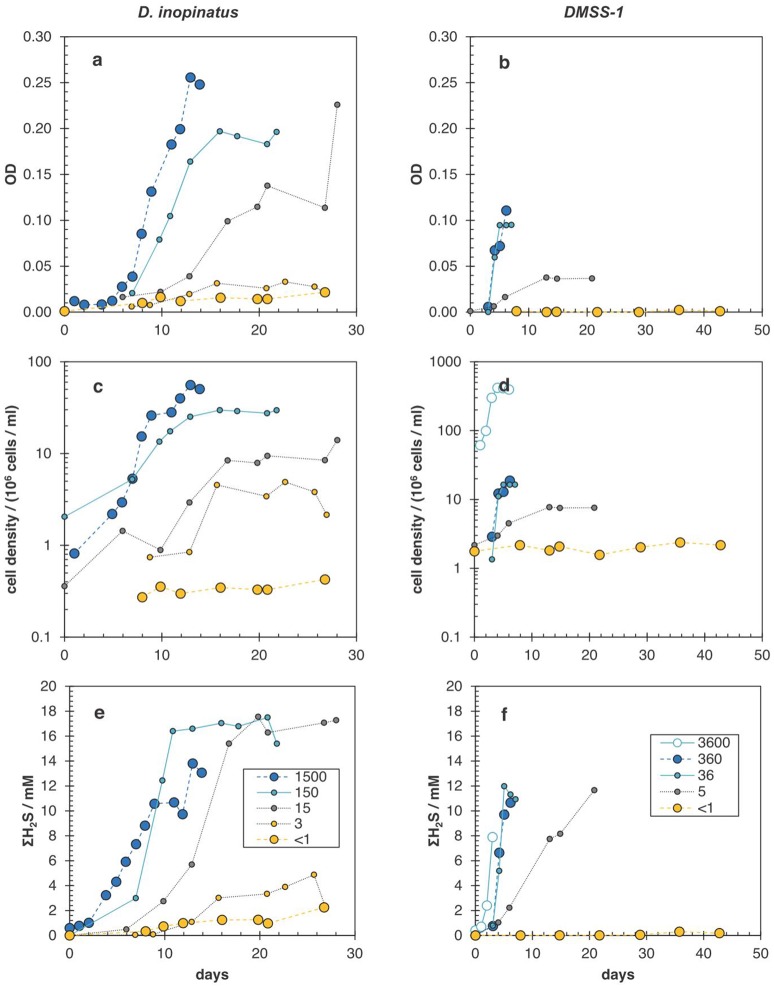
Growth curves showing optical density of cultures (a,b), cell densities determined by epifluorescence microscopy (c,d), and total sulfide (ΣH2S) concentration (e,f) in batch cultures of D. inopinatus (left) and DMSS-1 (right) grown on lactate in the presence of different initial phosphate concentrations (in μM; legend shown in bottom panels). Data are from Tables 2, 3, with the exception of the data for DMSS-1 cultures grown at 3600 μM phosphate (open circles in right panels), which are from Sim et al. (2011b). Note the difference in scales for the time axis between left and right panels. The uncertainties in cell density and sulfide concentration, respectively, were ±15% and ±10%, respectively.